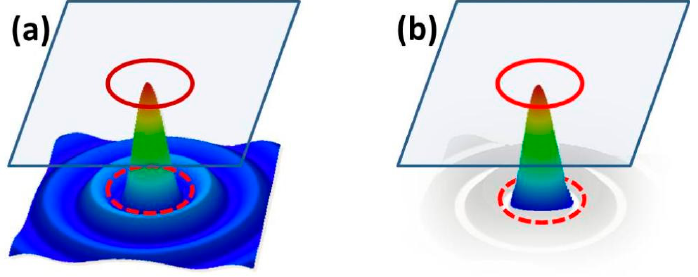
Figure 1. Principle of self-apodization with a truncated Bessel beam. Diffraction at hard edges of an aperture is minimized by adaptive beam pre-shaping. The light profile acts as the filter function (schematically). ( a ) unfiltered Bessel beam, ( b ) truncated Bessel beam. For a thin circular aperture at monochromatic illumination, a special self-apodization condition is well-approximated by a truncated Bessel function with first zero radius equal to the aperture radius [44,45].